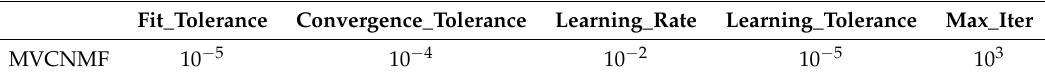
Table 1. MVCNMF parameter values.